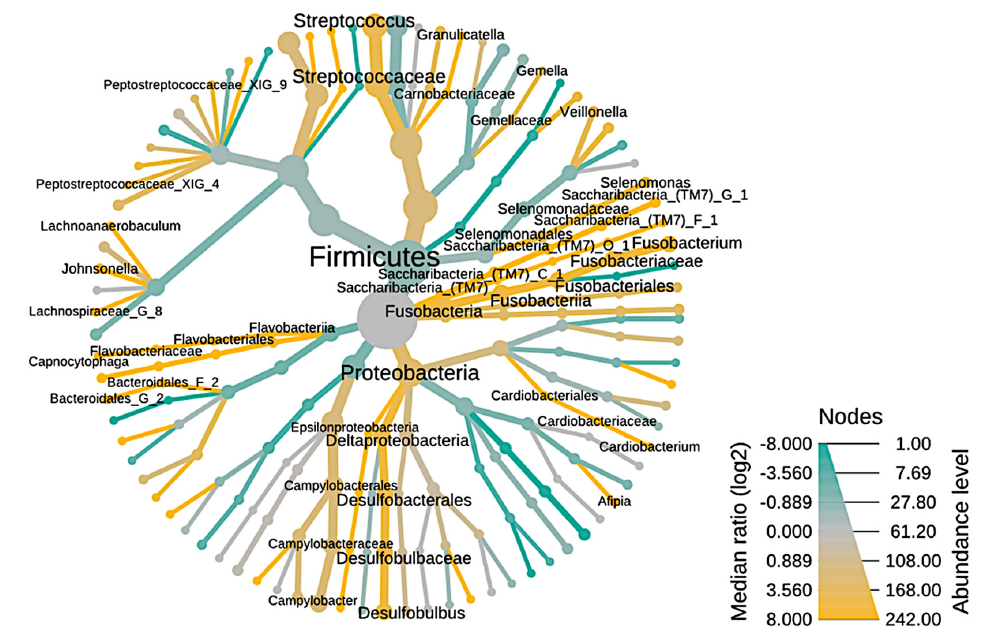
Figure 4. Heat tree illustrating the general taxonomy of the bacterial community through root canals in relation to periodontal pockets. The nodes represented by the green color are the most abundant (enriched) in RCs, the yellow ones are the most prevalent in PPs. The nodes represented by the gray color are present in the same proportion in both study